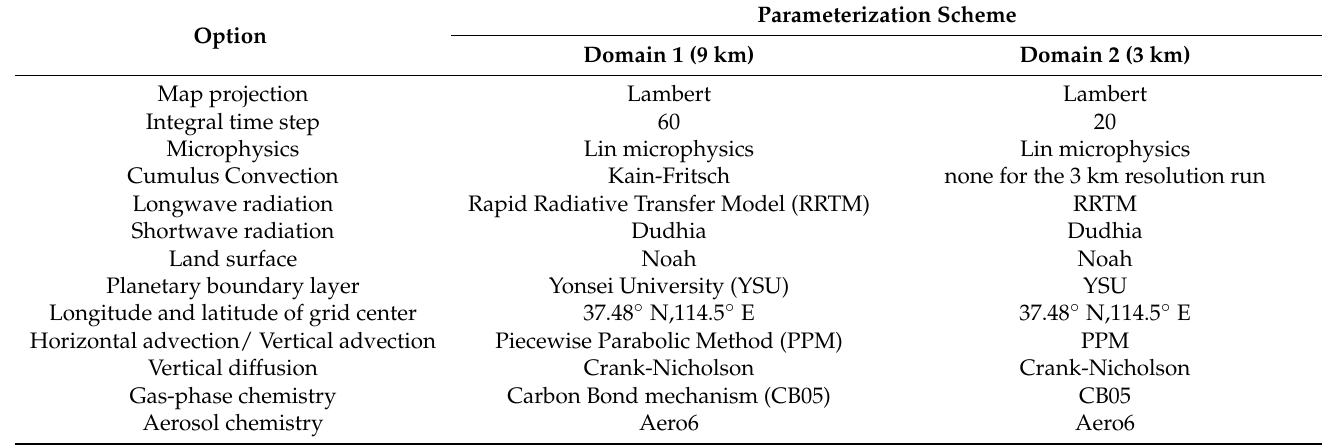
Table A1. Model configurations and